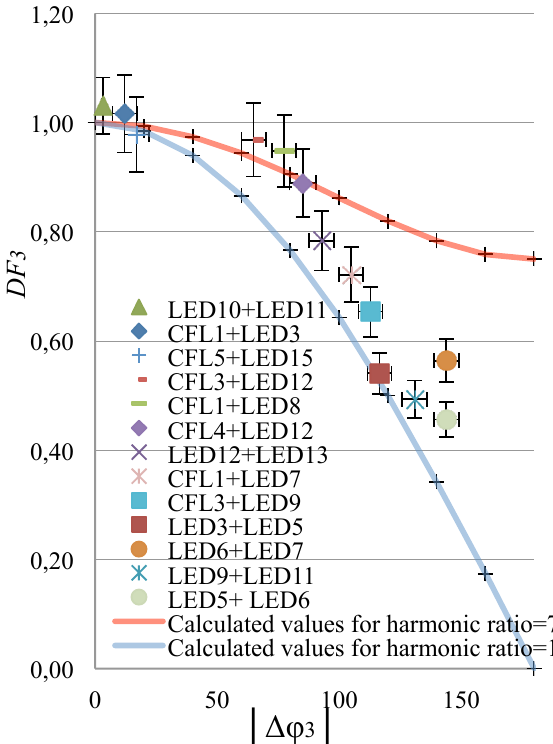
Figure 6: Attenuation of the third harmonic by combination of lamps. See text for details.